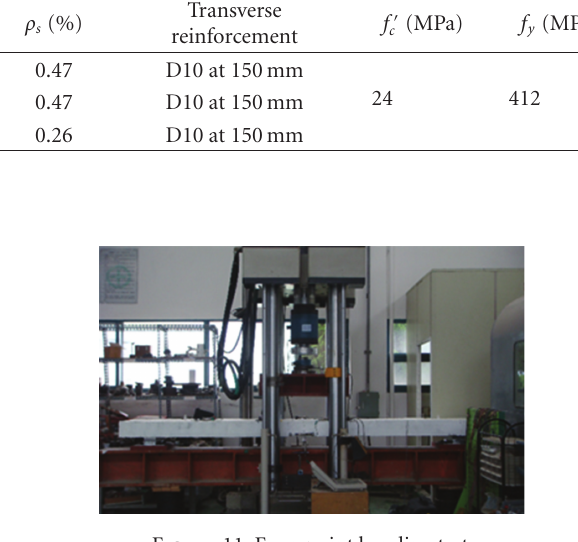
Figure 11: Four-point bending test.